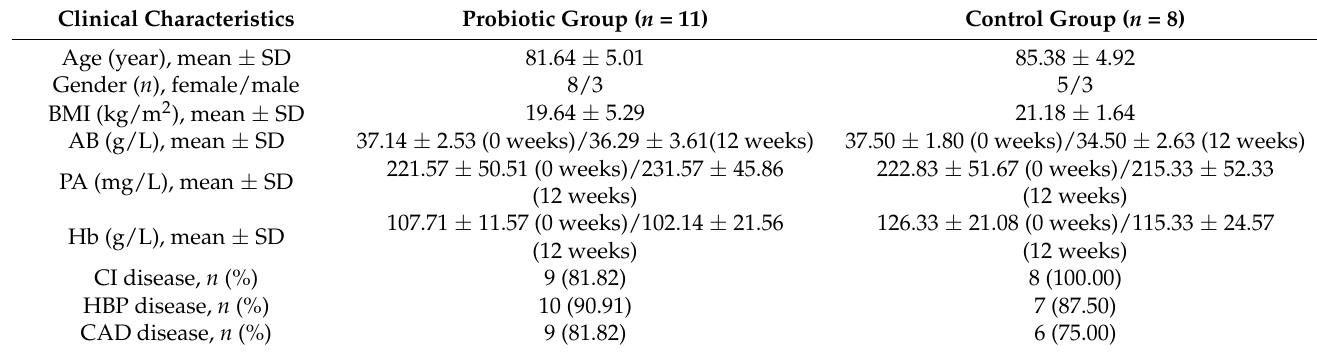
Table 1. Clinical characteristics of the